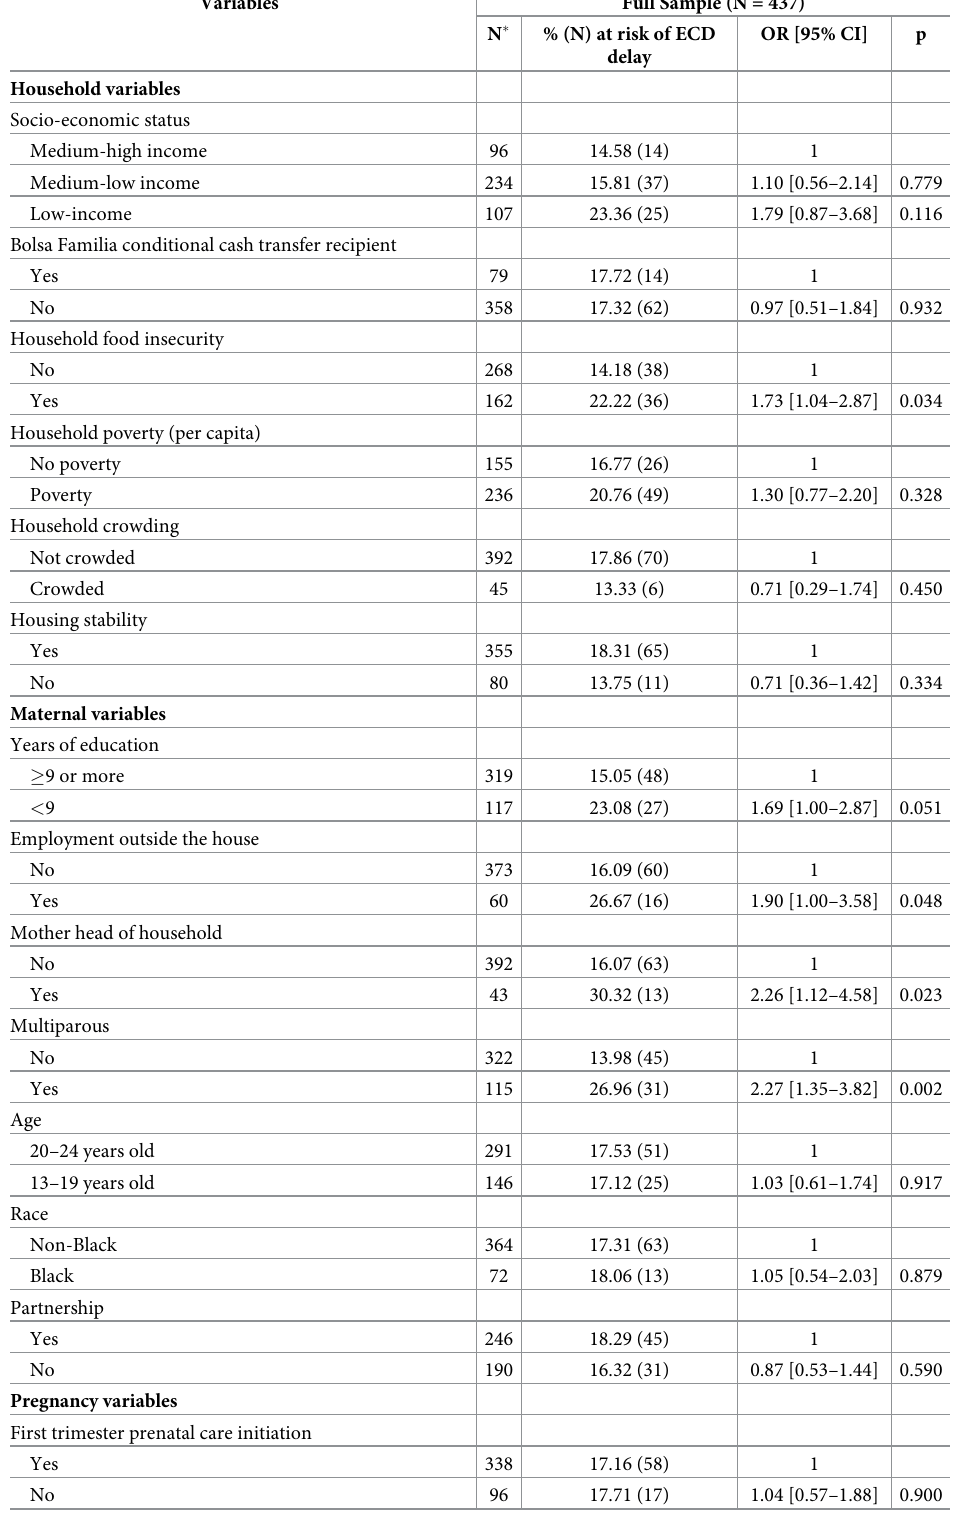
Table 2. Unadjusted odds ratio (OR) and 95% confidence interval (CI) for risk of ECD delay among children under 2 years old of adolescent and young adult mothers, Brası´lia, Brazil,